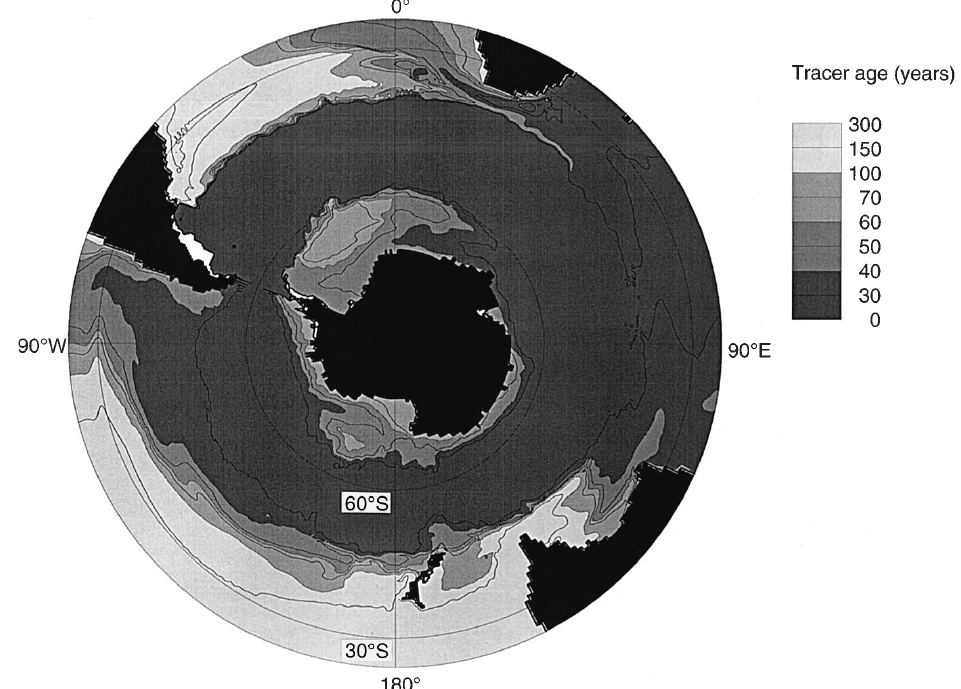
Fig. 8. A horizontal section at 120 m illustrating the age of tracer introduced at the Drake Passage (71 (cid:14) W)